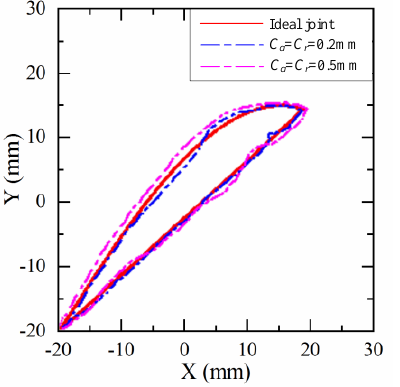
Figure 11. The path of the end effector geometric center in the XOY plane.